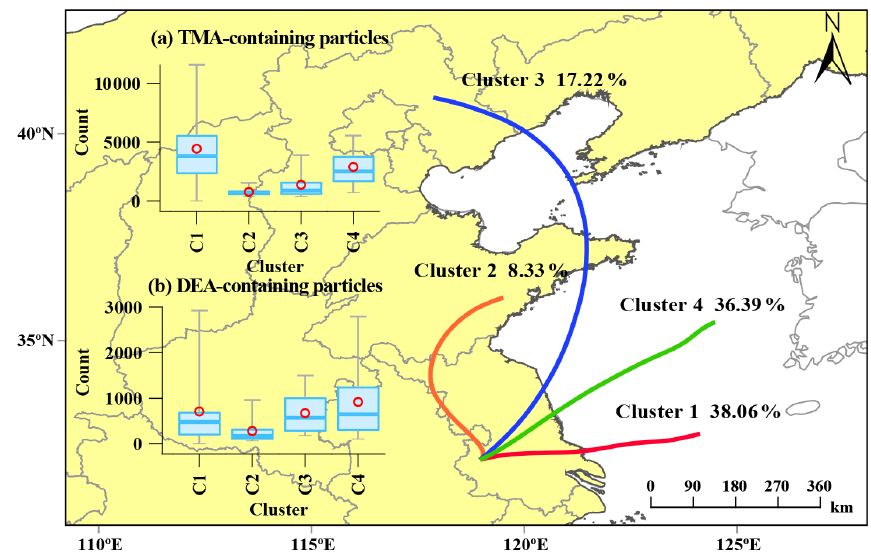
Figure 2. Backward trajectories (48h) of air masses at 500m above the ground during the sampling period, with (a) TMA-containing particles counts and (b) DEA-containing particle counts. C1 to C4 represent cluster 1 to cluster 4.